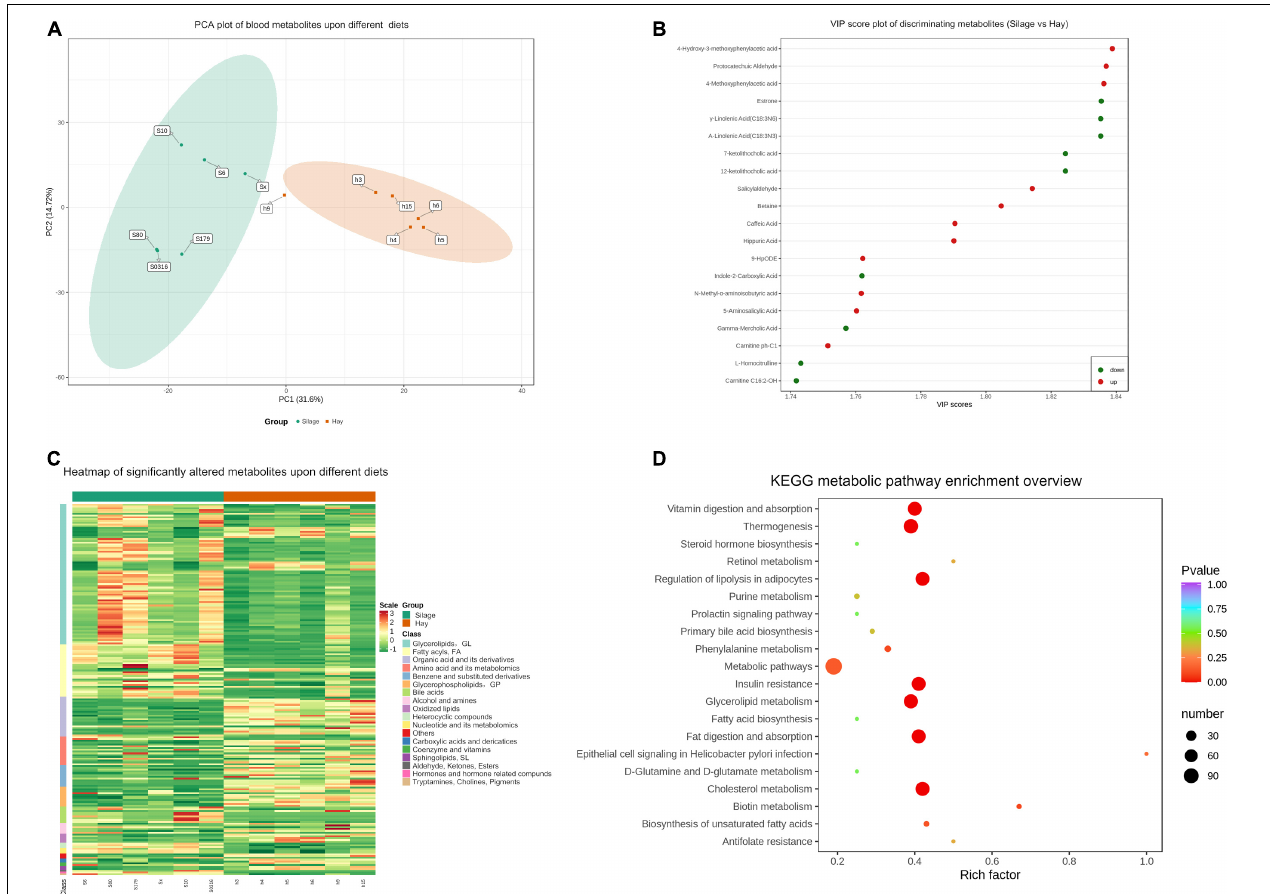
FIGURE 4 | Effect of ryegrass silage on horse metabolite profiles. (A) Principal component analysis (PCA) of blood metabolites of group S and group H. Green dot: PCA value of individual horse in group S. Orange rectangle: PCA value of individual horse in group H. (B) Metabolites discriminating between group S and group H with VIP > 1 were listed. Red dots indicate up-regulated metabolites. Green dots indicated down-regulated metabolites. (C) Heatmap of significantly altered metabolites in group S and group H. Individual samples (horizontal axis) and metabolites (vertical axis) are presented using hierarchical cluster analysis. The color scale is noted on the right side of the figure. Red and green color represent up-regulated and down-regulated metabolites, respectively, relative to the median metabolite level. (D) KEGG enrichment of each pathway related to this study was presented using rich factor. P -values and impact values are indicated on the horizontal axis and vertical axis, respectively. The sized and colors of the shapes represent the influence of silage diet on sample pathways relative to hay diet. The larger red shapes indicate greater impact of the diet on the